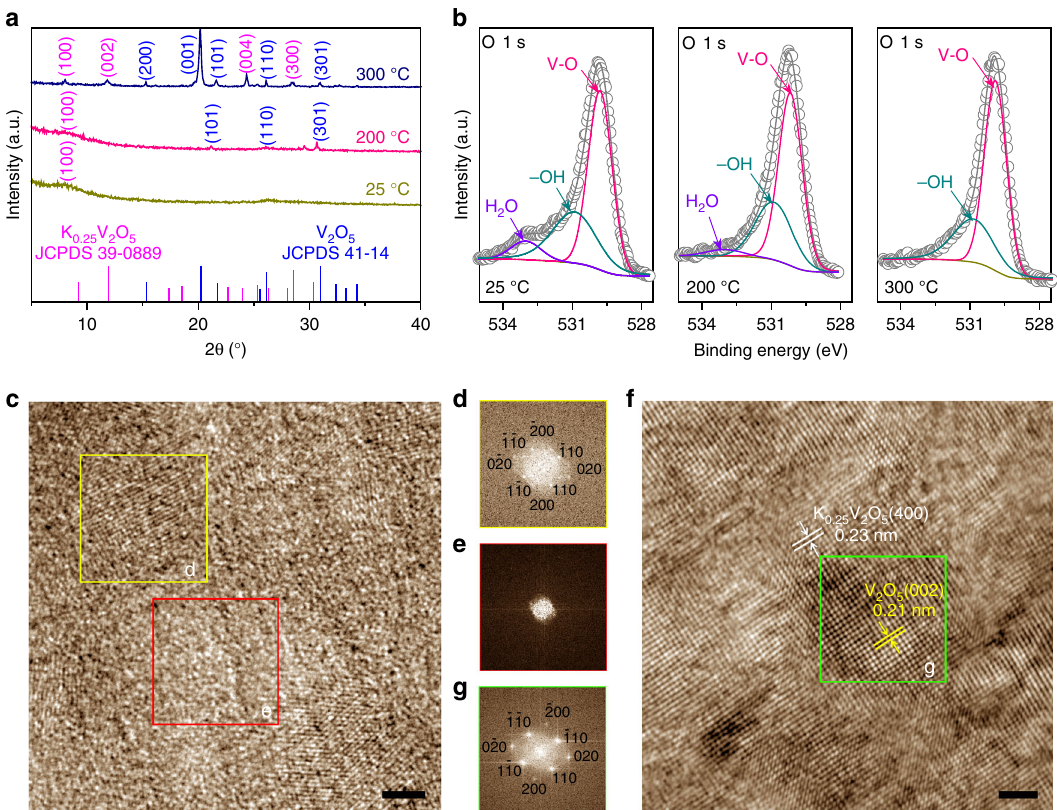
Fig. 2 Microstructural characterization of the constituent K x V 2 O 5 . a XRD patterns of layered K x V 2 O 5 ( x = 0.25) that is annealed at 25, 200, and 300 °C. The line patterns show reference cards 39 – 0889 and 41 – 1426 for layered K 0.25 V 2 O 5 and V 2 O 5 according to JCPDS. b High-resolution XPS spectra of O 1s in the layered K x V 2 O 5 ( x = 0.25) that is annealed at 25, 200, and 300 °C. c HRTEM image of the layered K x V 2 O 5 ( x = 0.25) with a dual-phase nanostructure that is produced by annealing at 200 °C. d , e FFT patterns of layered K x V 2 O 5 with crystalline region (yellow box) ( d ) and amorphous region (red box) ( e ). f HRTEM image of the layered K x V 2 O 5 ( x = 0.25) with a complete crystallization at annealing temperature of 300 °C. g FFT pattern of layered crystalline K x V 2 O 5 (green box). Scale bar, 2 nm ( c , f ) Table 1 XRD and electrochemical results of layered K x V 2 O 5 and V 2 O 5 supported by nanoporous Au current microcollectors Materials Interlayer space